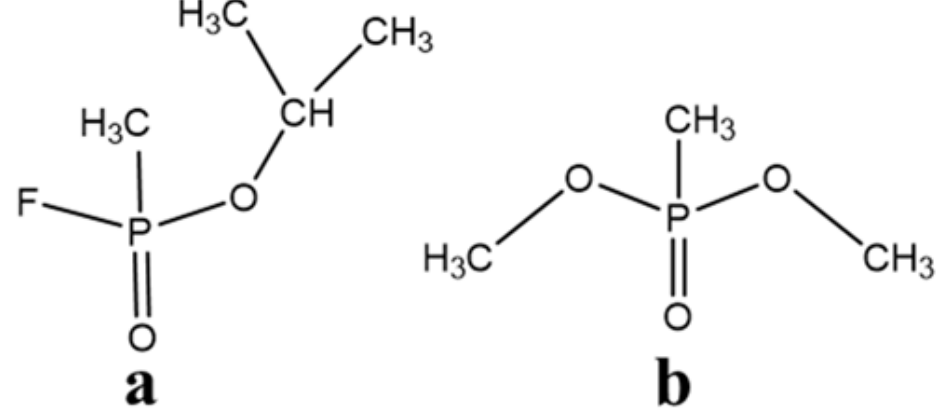
Figure 1. The chemical structure of ( a ) sarin and ( b ) DMMP.